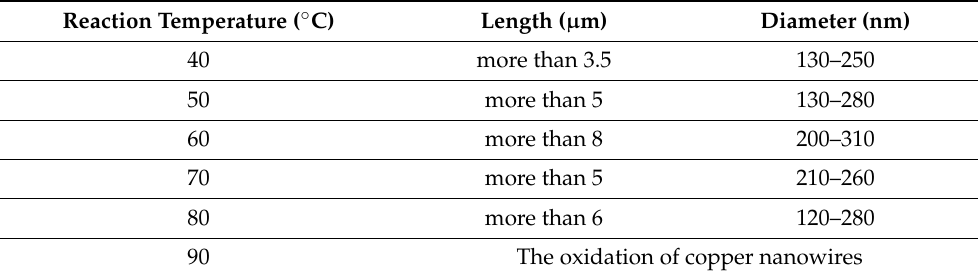
Table 2. Dimensions of copper products synthesized at various reaction